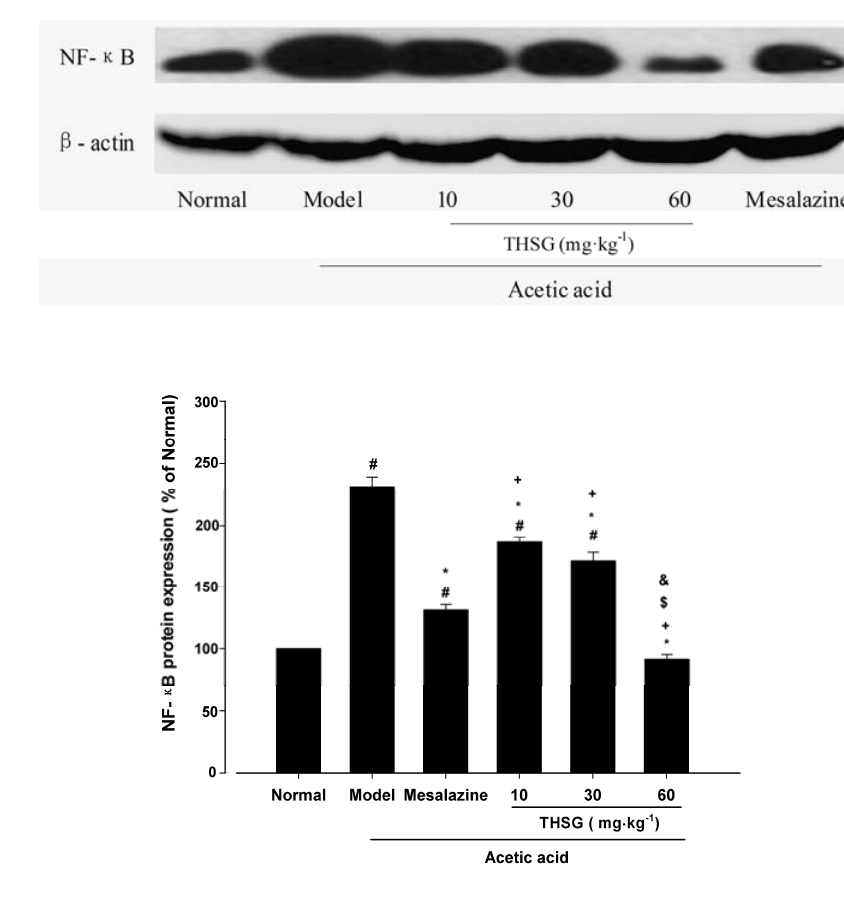
Figure 6. Effect of THSG on the expression of NF- κ B in colonic tissues of mice treated with acetic acid assessed by Western blot analysis. ( A ) Immunoreactive bands of NF- κ B and actin using specific antibody. Actin was used as an internal control. ( B ) Histogram representing the quantitative analysis of NF- κ B level normalized to actin protein. Data are expressed as means ± SEM (n=6 for each group). # p < 0.05 versus Normal group; * p < 0.05 versus Model group; + p < 0.05 versus Mesalazine group; $ p < 0.05 versus THSG 10 group; & p < 0.05 versus THSG 30